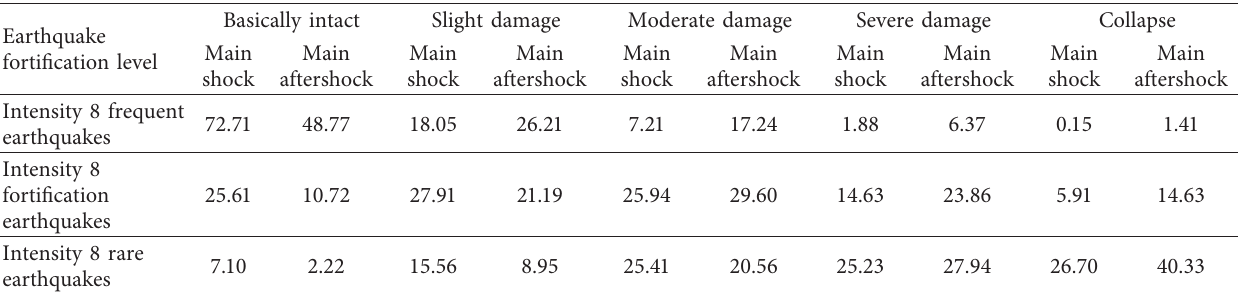
Table 12: Seismic vulnerability matrix of the structure under main shock and main aftershock ground motion (%).